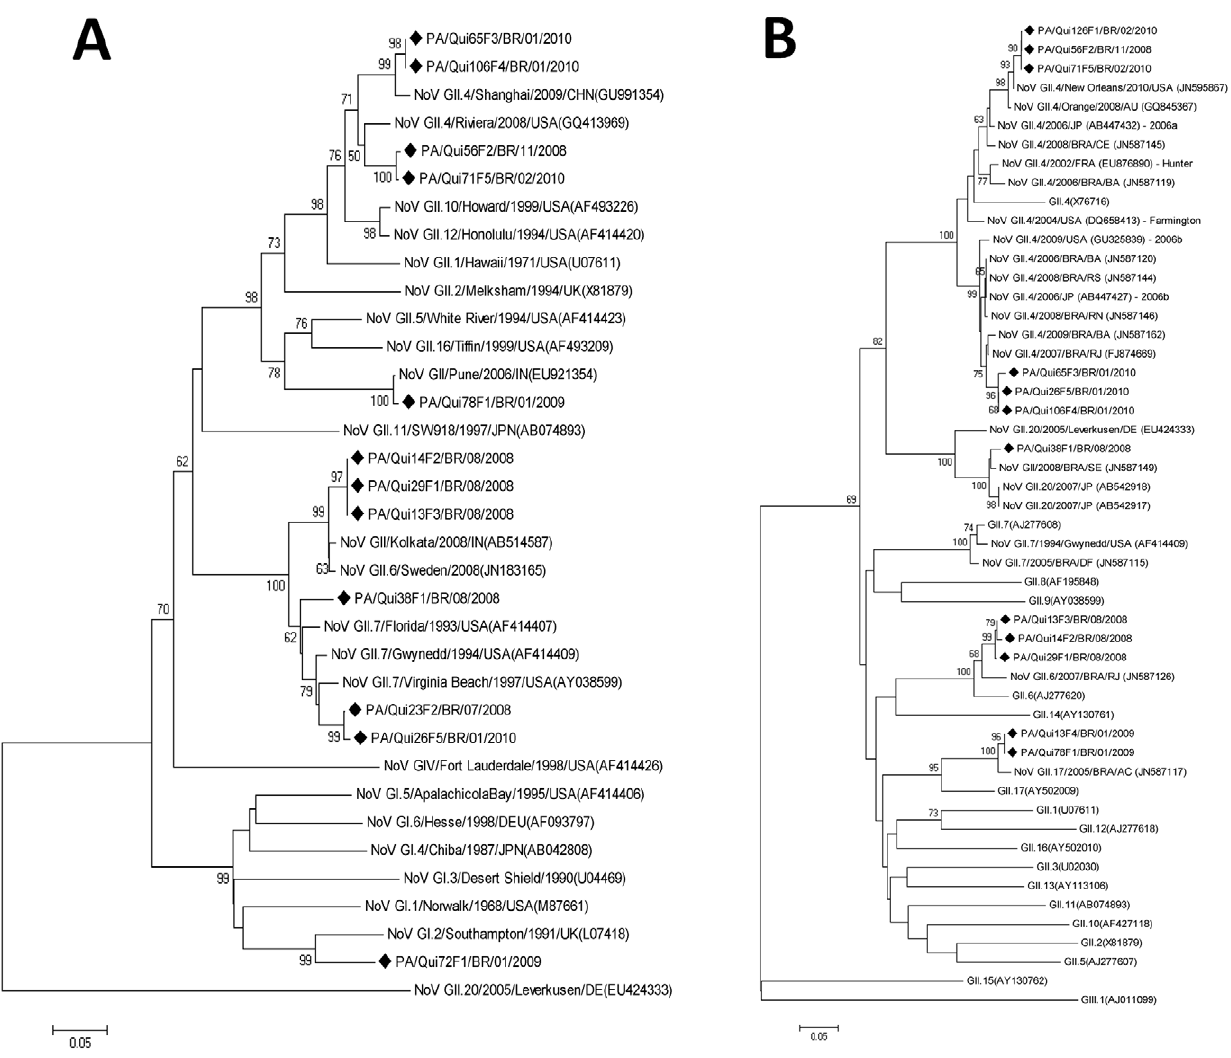
Figure 2. Dendograms constructed using the partial region of the norovirus RNA polymerase sequence (ORF1-B) (A) and capsid region (ORF2-D) (B) amplified from 14 strains from diarrheic children of Abacatal ‘‘Quilombola’’ Community, metropolitan region of Bele´m, Para´ State, Brazil. April/2008 to July/2010. Prototype strains are presented together with strains from other locations. The number above each branch corresponds to the bootstrap value (2,000 replicates). The scale bar is proportional to the genetic distance. Study samples were marked ( ¤ ): PA-local/Qui-code in the study + F x -Number of the stool/country/month + year of collection.